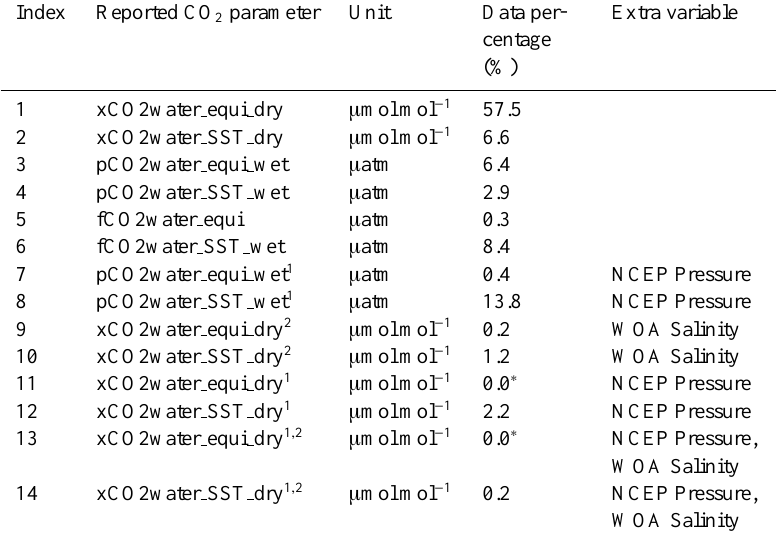
Table 4. Surface water CO 2 parameters reported in the original data files, which have been used for the calculation of recommended f CO 2 (fCO2 rec) at sea surface (or intake) temperature (Pfeil and Olsen, 2009). The parameters are listed in order of preference (with index 1 as the favourite). The index has been reported in the SOCAT global and regional output files as “fCO2 source” (Table 5). Ancillary parameters have been used for NCEP (National Centers for Environmental Prediction) atmospheric pressure (Kalnay et al., 1996) and WOA (World Ocean Atlas) salinity (Antonov et al., 2006) (Sect. 3.3) in cases of incomplete data